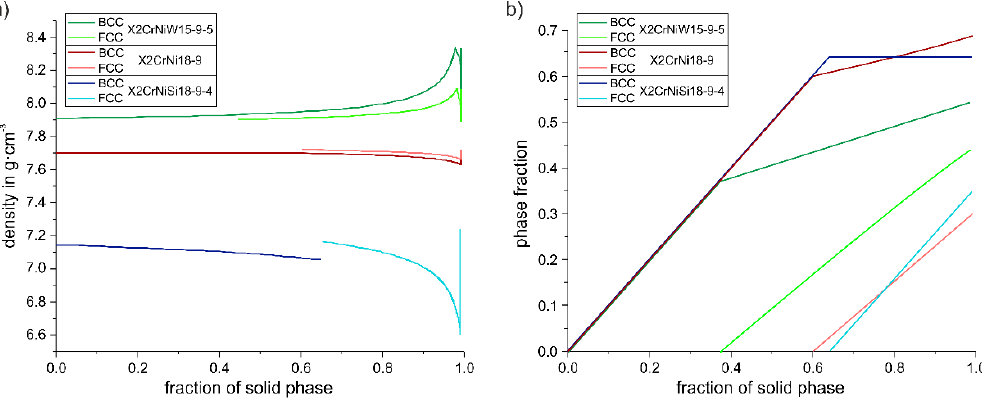
Figure 2. Results derived from the Scheil–Gulliver solidification simulations (Thermo-Calc 2020b, TCFe10 database). ( a ) The density profiles of both solidifying phases in each steel; ( b ) the corresponding fractions of the solidified phases.